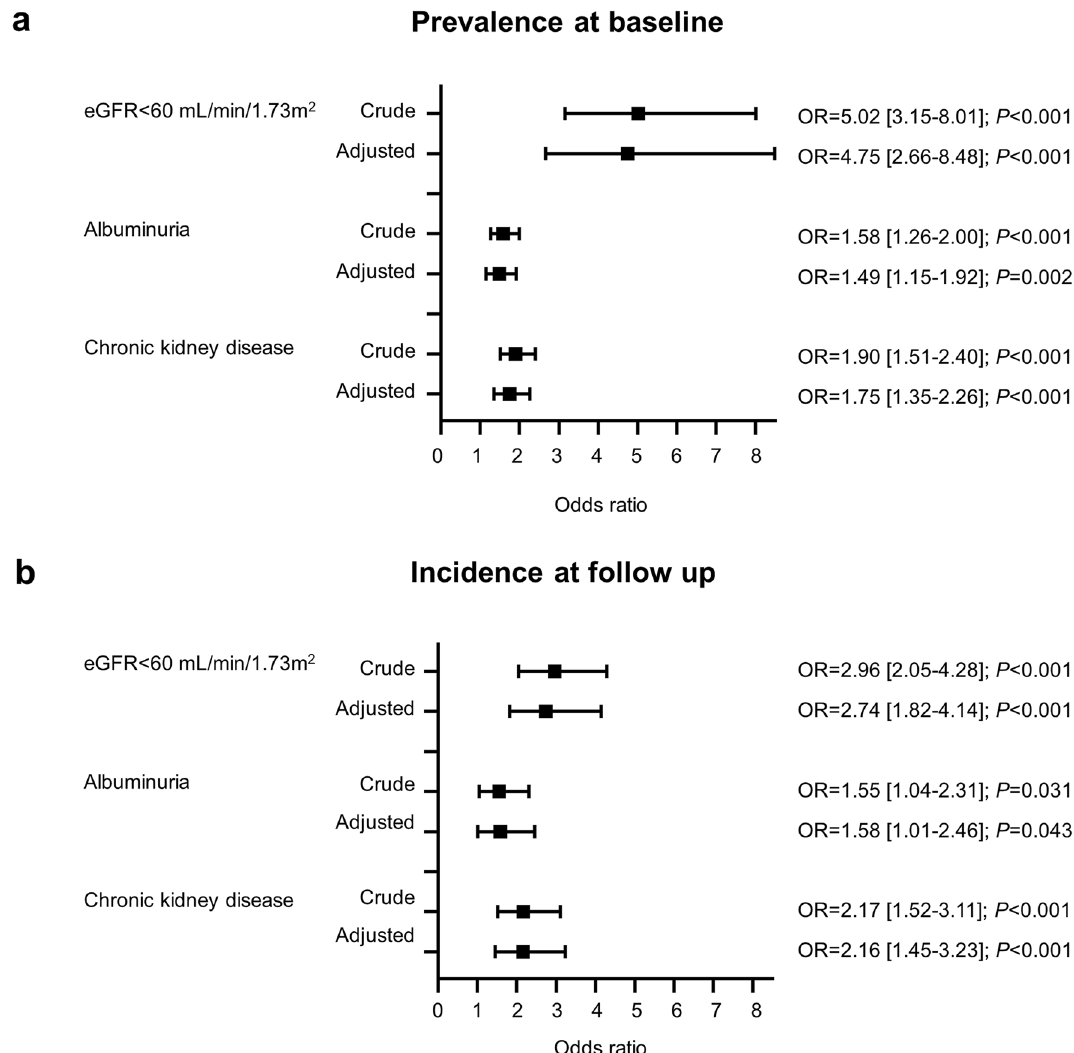
Figure 2. Associations between glypican-4 levels and ( a ) prevalence of eGFR < 60 mL/min/1.73 m 2 , albuminuria, and chronic kidney disease at baseline or ( b ) incidence of newly diagnosed eGFR < 60 mL/ min/1.73 m 2 , albuminuria, and chronic kidney disease at follow up. Chronic kidney disease was attested in case of eGFR < 60 mL/min/1.73 m 2 or albuminuria. Odds ratios with 95% confidence intervals [95%CI] per standard deviation of log-transformed GPC4 were obtained by univariable (crude) and multivariable logistic regression analyses adjusted for age, sex, body mass index, systolic and diastolic blood pressure, type 2 diabetes mellitus, history of smoking, C-reactive protein, and significant coronary artery